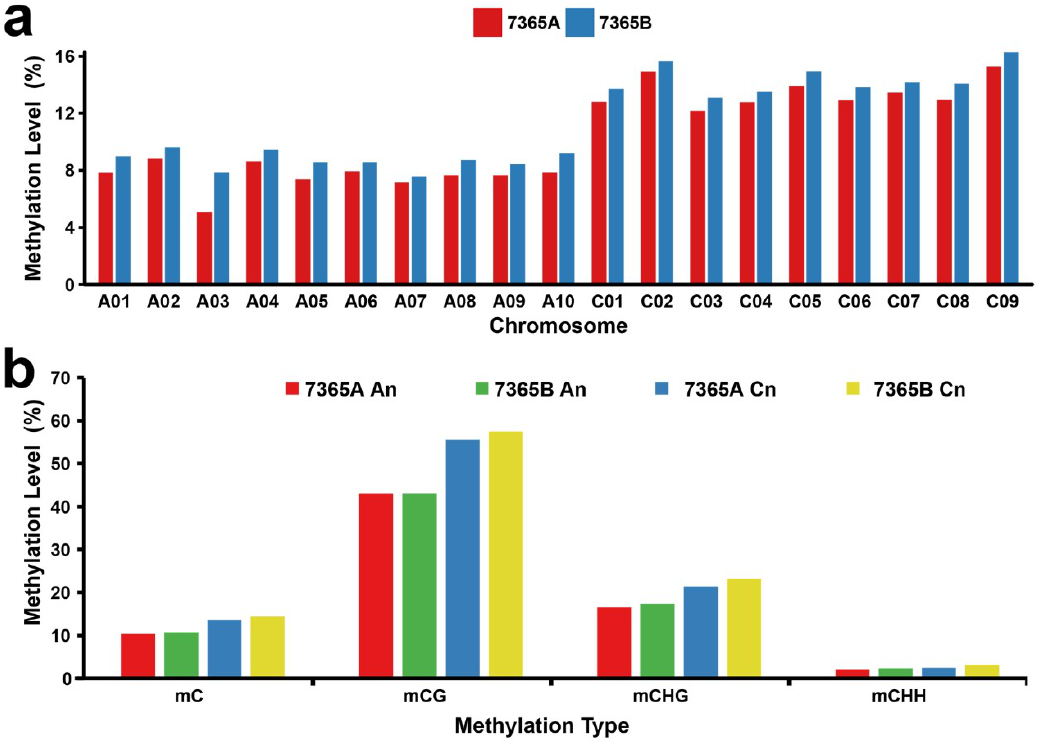
Figure 3. Chromosomal distribution of the global DNA methylation patterns of 7365A and 7365B. ( a ) DNA methylation levels in nineteen chromosomes. ( b ) Mean DNA methylation levels of the A n and C n subgenomes.